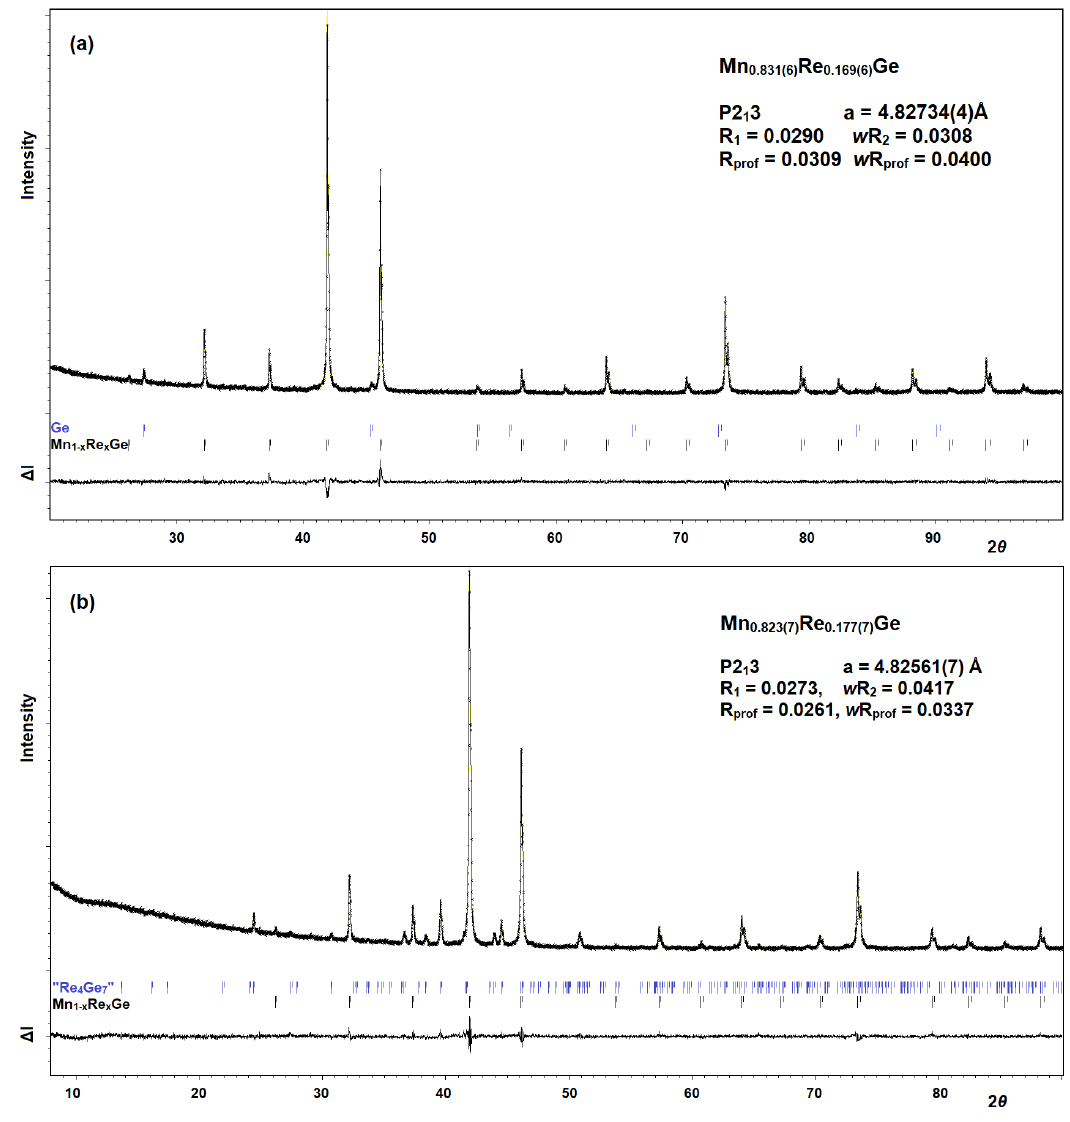
Figure 2. Powder X-ray diffraction patterns of Mn 1 − x Re x Ge ( x nominal = 0.17 ( a ) and 0.20 ( b ), which correspond to the refined compositions x refined = 0.169(6) ( a ) and 0.177(7) ( b )). The upper black line represents the experimental diffraction patterns, the ticks show peak positions, and the lower black line is the difference between the experimental and calculated patterns.